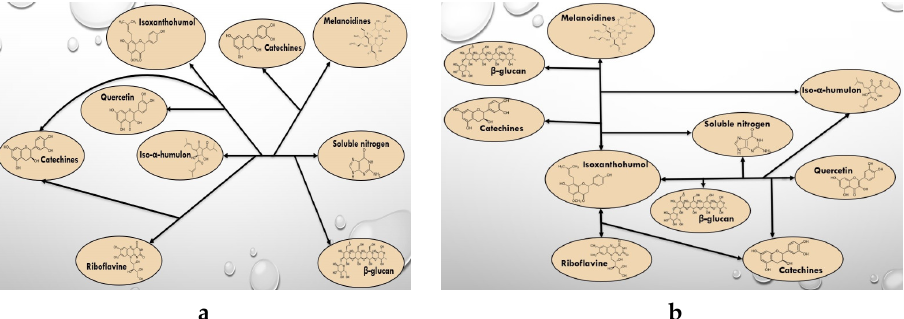
Figure 3. The organic compounds influence on iso-α-humulone ( a ) and isoxanthohumol ( b ) content of different adjuncts of beer samples.